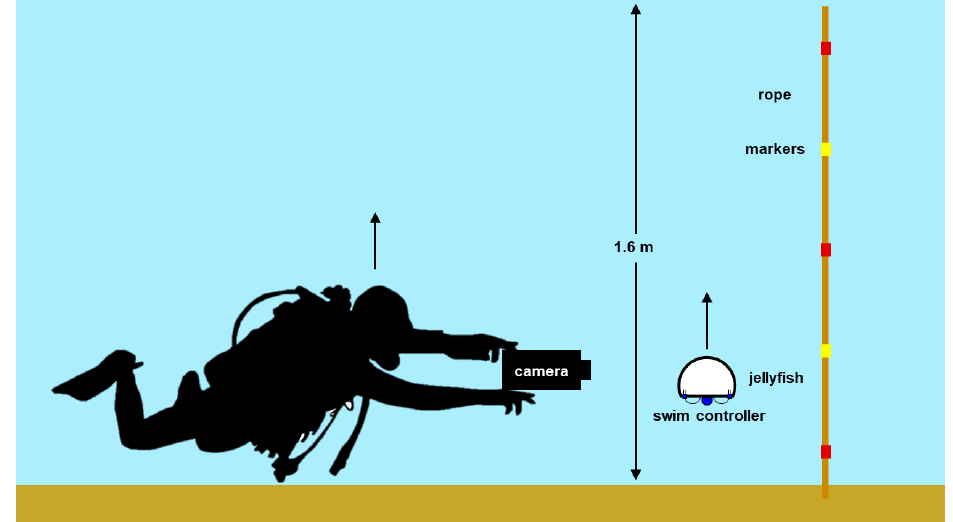
Figure 2. Setup of field experiments. Simplified schematic of the experimental setup, including a scientific diver holding a camera that tracks a biohybrid robotic jellyfish (swim controller and jellyfish) swimming upwards from the ocean floor to the surface, 1.6 m in depth. A rope with alternating red and yellow markers is used to track displacement during image analysis.